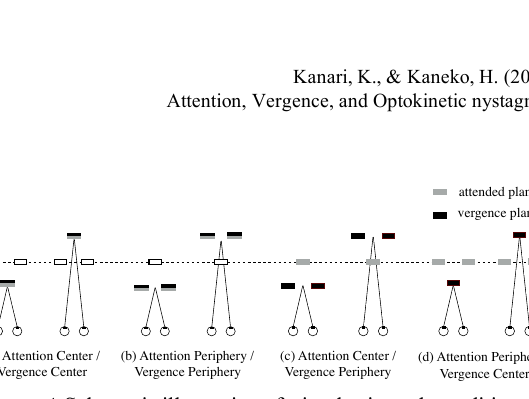
Figure 4. Schematic illustration of stimulus in each condition. All panels show top view. Gray and black squares, respectively, show depth planes where attention was paid and vergence was directed. Dotted lines show the plane of display. See texts for the